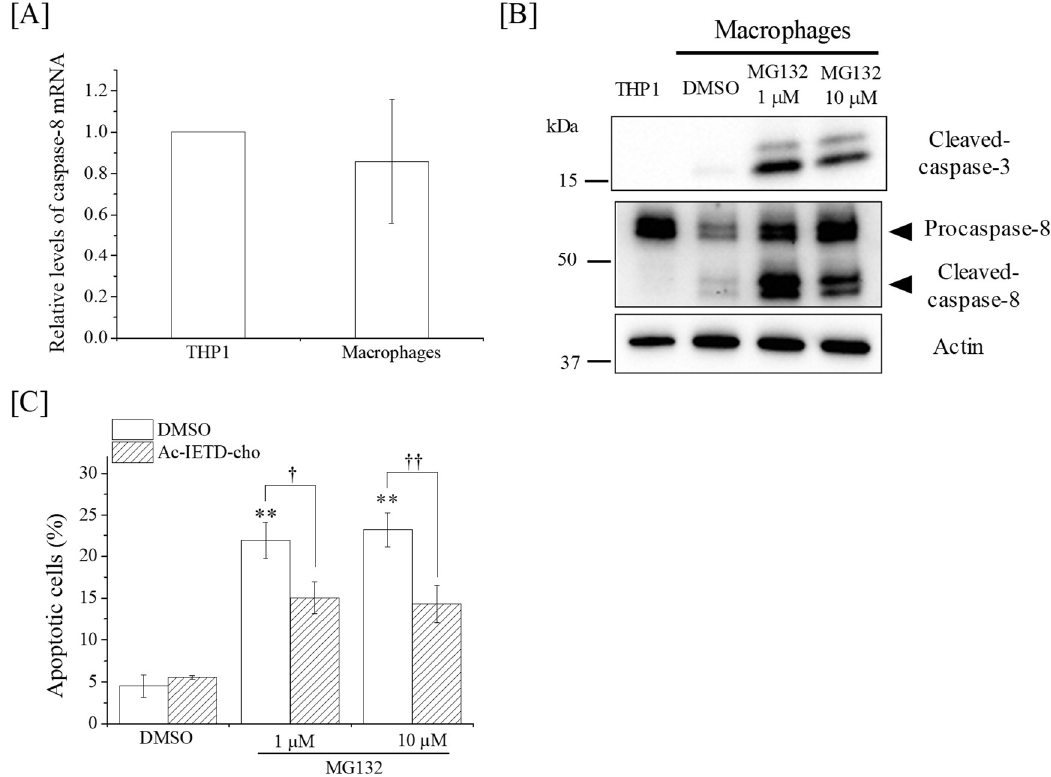
Figure 5. Effects of MG132 on the caspase-8 expression and apoptosis induction in macrophages. ( A ) The caspase-8 mRNA expression of THP-1 cells and macrophages were analyzed using quantitative reverse transcription polymerase chain reaction (qRT-PCR). Data are presented as the mean ± SD of four independent experiments. ( B ) Macrophages were cultured in the presence of the proteasome inhibitor MG132 or DMSO. The cells were cultured for 24 h and harvested for Western blot analyses of caspase-3 and -8. The expression of β -actin was analyzed as a loading control. ( C ) Macrophages pretreated with the caspase-8 inhibitor Ac-IETD-cho or DMSO were cultured in the presence of MG132. The cells were cultured for 24 h and harvested for the detection of apoptosis. Data are presented as the mean ± SD of three independent experiments. ** p <0.01 vs. DMSO control. † and †† indicate p < 0.05 and p <0.01, respectively.